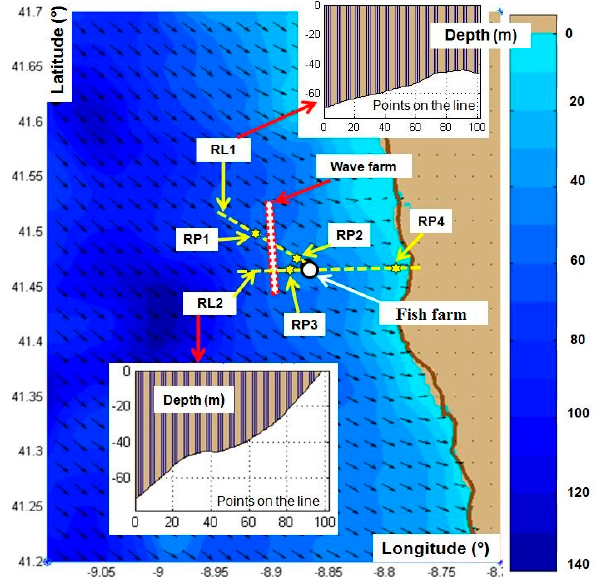
Figure 3. In the background, the bathymetric map of the SWAN computational domain is presented while the black arrows suggest the most common pattern for the wave propagation in the target area. In the foreground, the location of the fish farm is indicated, together with the generic wave farm. The positions of two reference lines (RL1, RL2) and of four reference points (RP1–RP4) further considered in the analysis are also indicated. The variations of the water depth considering 100 equally spaced points along the reference lines are also represented.